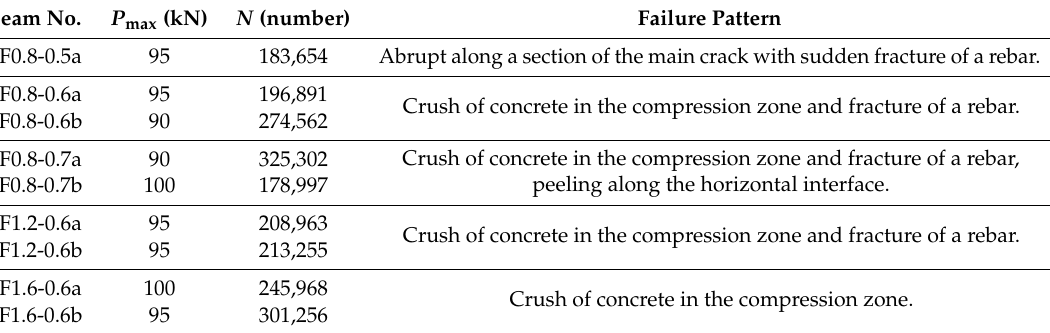
Table 3. Fatigue life and failure mode of test beams.